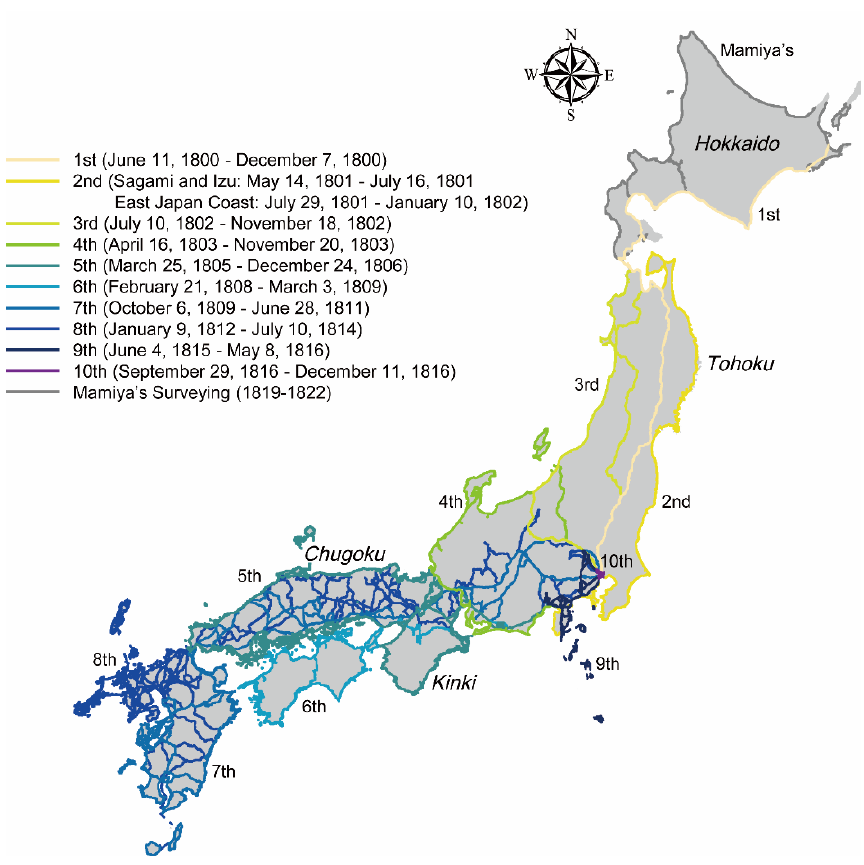
Figure 1. Roads and coastlines in Inoh’s map. The date of the survey is based on [10]. Mamiya Rinzo learned surveying from Inoh Tadataka, and he was in charge of surveying Hokkaido (Ezo) [11]. Source: Digital Inoh’s Map.